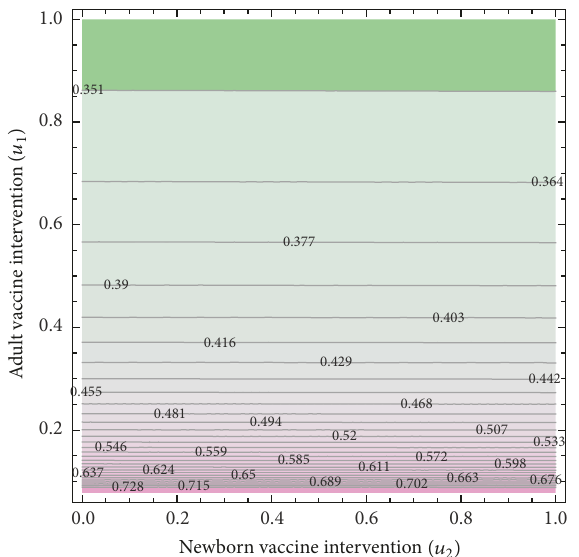
Figure 4: Sensitivity analysis of R 0 with respect to dengue intervention in human